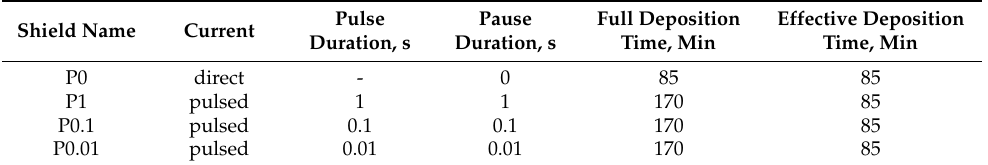
Table 1. Technological features of obtaining FeNi shields in direct current (DC) and pulse deposi- tion